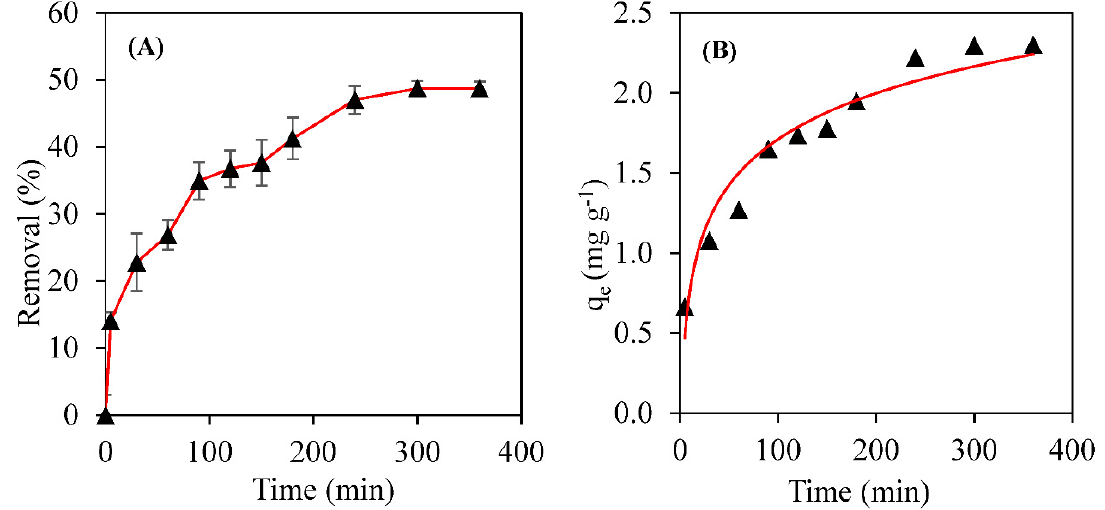
Figure 3. Equilibrium time for the CPX antibiotic. ( A ) the percentage of removal as a function of time; and ( B ) the amount adsorbed as a function of time.